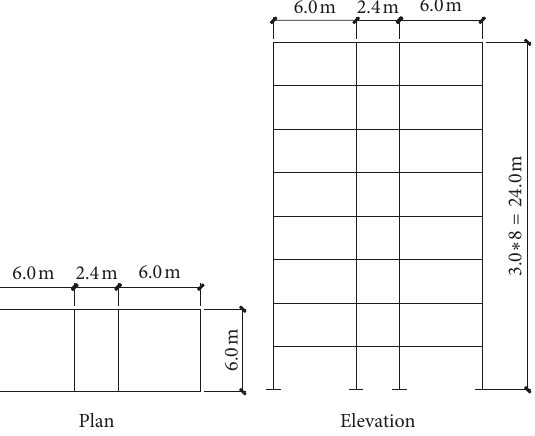
Figure 1: Dimensions of the fixed-base model.